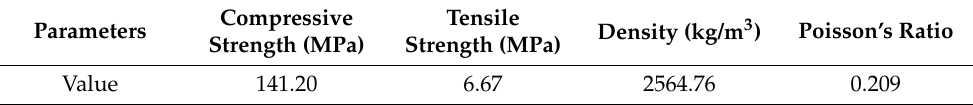
Figure 4. The numerical simulation model of a conical pick cutting rock. Table 1. Rock material key parameters.